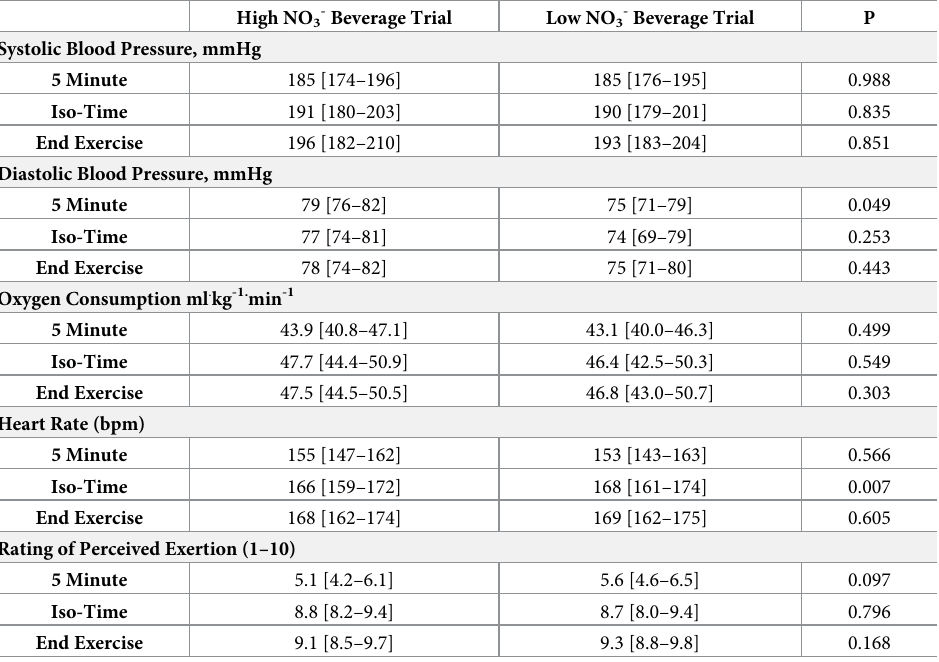
Table 2. Exercise responses during the high and low NO3- beverage trials.